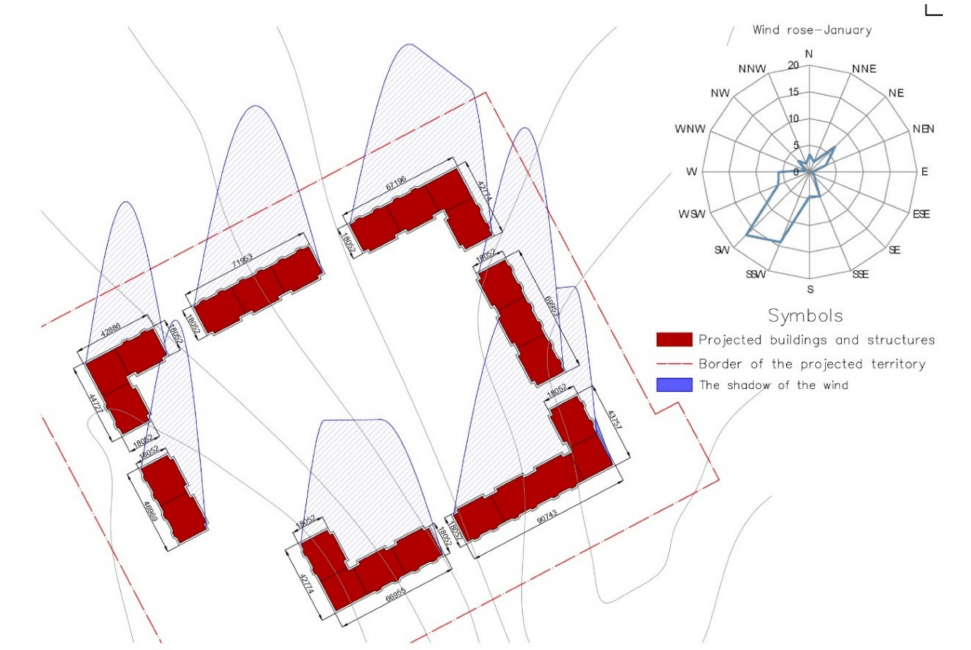
Figure 4. Typical residential perimeter block pattern and the wind rose for the Murmansk metropolitan